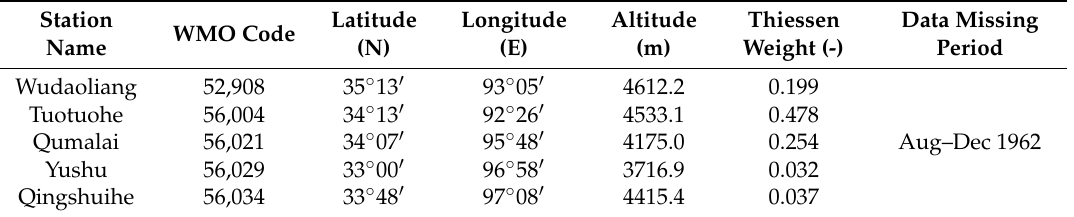
Table 1. List of the selected stations, including WMO (World Meteorological Organization) code, latitude, longitude, altitude, Thiessen weight, and data missing period during the study period.